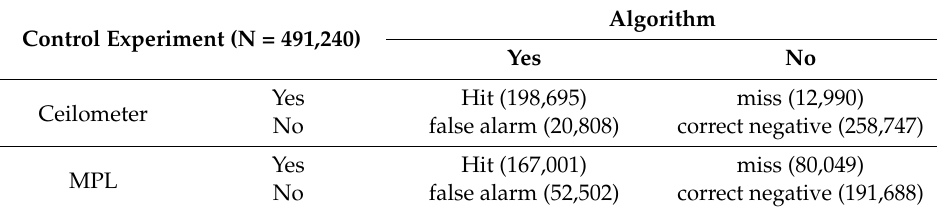
Table 6. Contingency table for the IRT cloud detection (the Control case which is for the original dataset) compared with the measurement of the ceilometer and MPL. The number inside the parenthesis is number of data corresponding to the case (among a total of 491,240 data points). Here, “No” in both ceilometer and MLP means there is no significant backscattering signal obtained from the measurement, which is regarded as clear